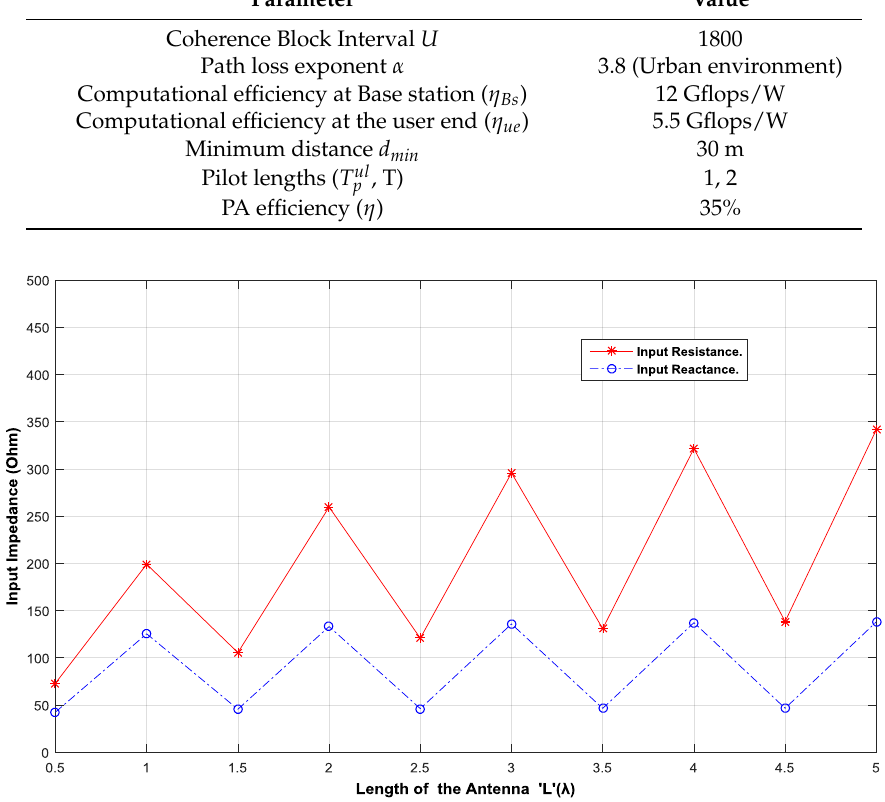
Figure 4. Input Impedance.